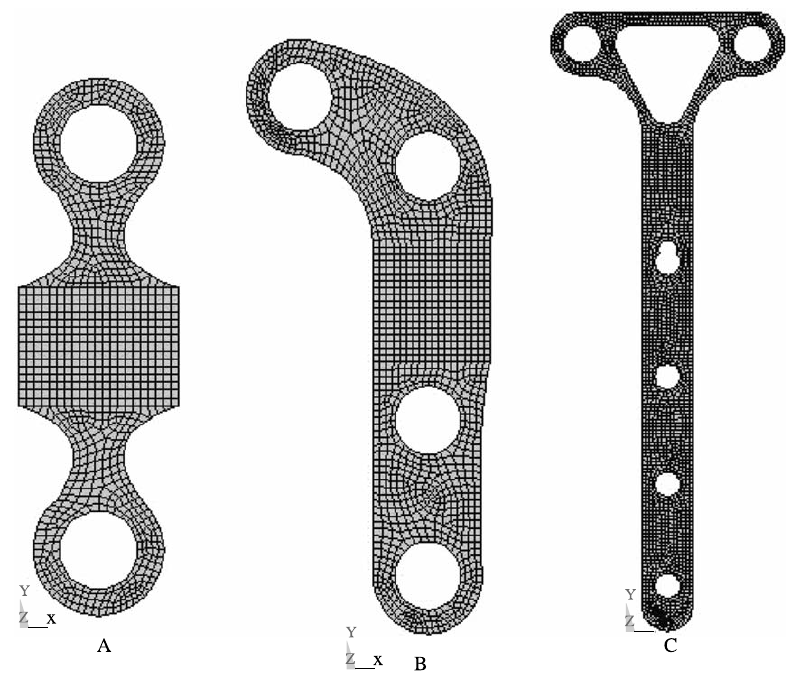
Fig. 9. Plates after Topology